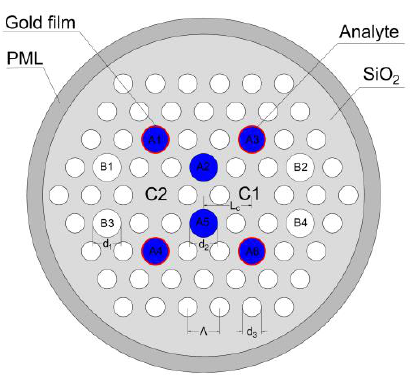
Figure 1. Schematic of the sensor.